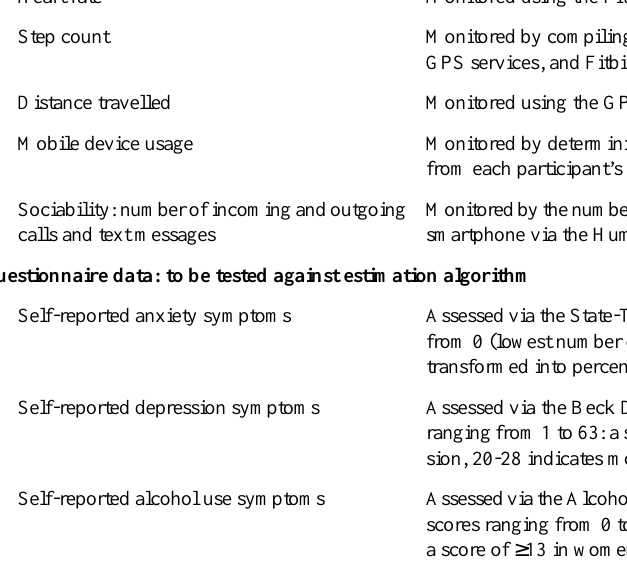
Table 1. Data collection by sensors compared with questionnaires. Sensor data: to be used to calculate estimation